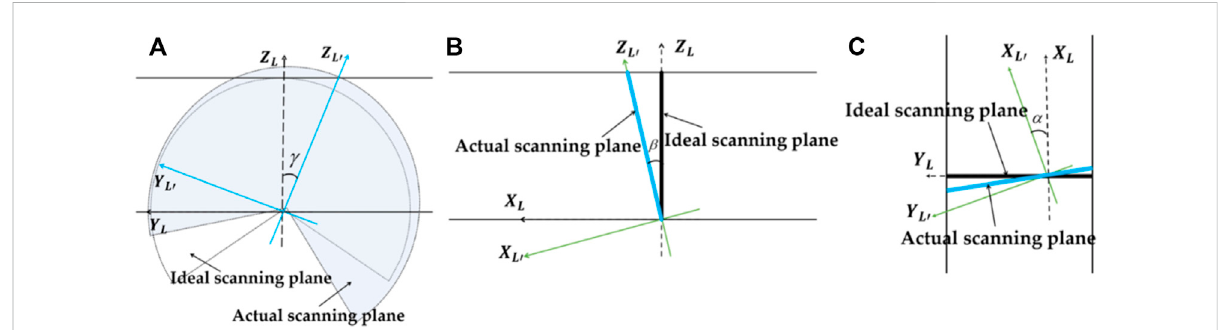
FIGURE 5 The comparison of the ideal and actual laser scanning plane due to the angular error about the three axes (A) x -axis (B) y -axis (C) z -axis.